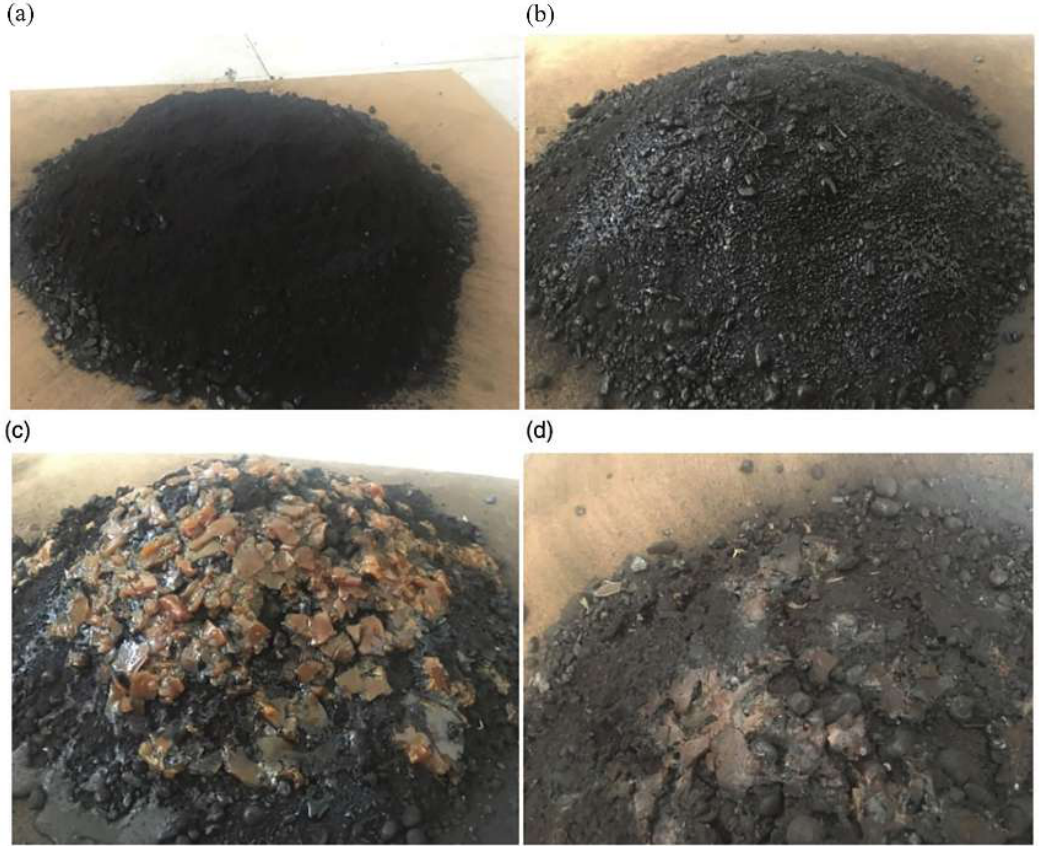
Figure 5. Pictures of the coal pile without and under di ff erent treatments: ( a ) Picture of the primary coal pile; ( b ) picture of the coal pile after being wetted; ( c ) picture of the coal pile after being coated with the coagulant; ( d ) picture of the coal pile after the application of coagulant [36].